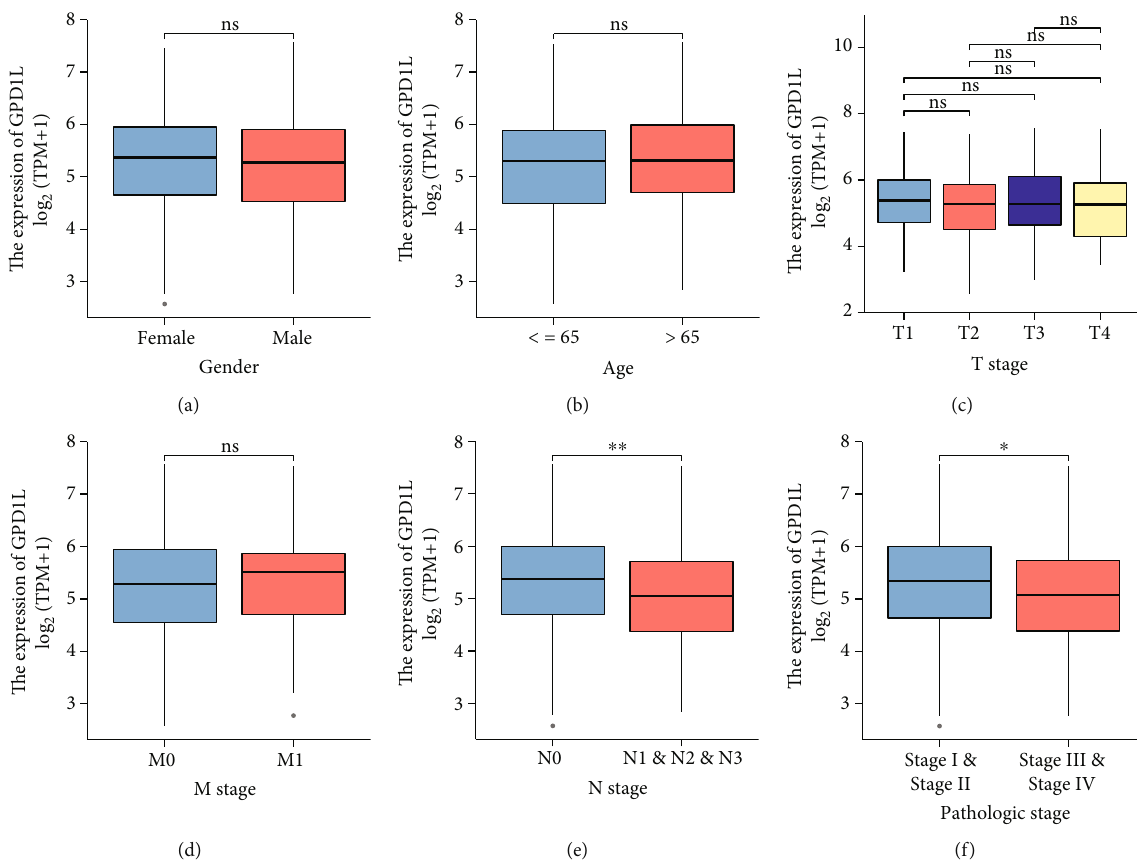
Figure 3: GPD1L expression and the clinical characteristics of LUAD patients have been found to have a correlation with one another. GPD1L expression was found to be associated with a number of clinicopathologic variables, such as (a) gender, (b) age, (c) T stage, (d) M stage, (e) N stage, and (f) pathologic stage. ∗ p < 0 : 05 , ∗∗ p < 0 : 01 , ∗∗∗ p < 0 : 001 ; ns: no signi fi